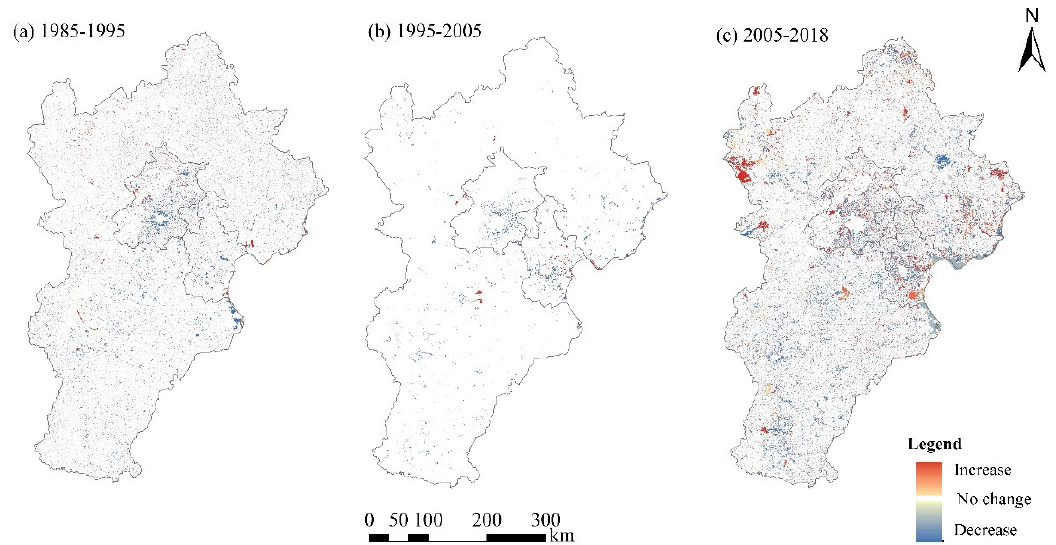
Figure 8. Spatial distribution of the changes in carbon storage from ( a ) 1985 to 1995, ( b ) 1995 to 2005, and ( c ) 2005 to 2018.